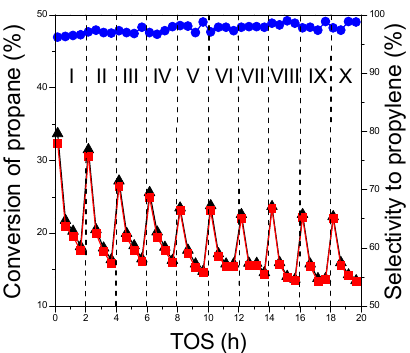
Figure 7. Variation of propane conversion ( ▲ ). propene yield ( ■ ) and selectivity ( ● ) with time-on- stream in consecutive I–X cycles over Cr20/Al 2 O 3 -n. Dehydrogenation conditions: reaction temperature = 550 °C; catalyst weight = 200 mg; feed gas composition C 3 H 8 :He =1:14; total flow rate = 30 cm 3 ·min − 1 . Regeneration conditions: temperature = 550 °C; total flow rate of air = 30 cm 3 ·min − 1 . Purification conditions: temperature = 550 °C; total flow rate of helium = 30 cm 3 ·min − 1 . TOS: time-on- stream.